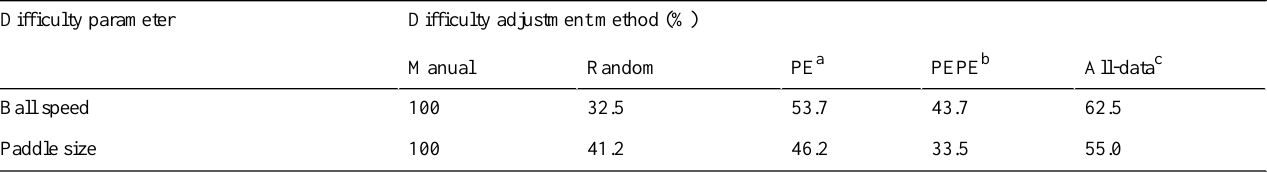
Table 2. Prediction accuracy of changes to the game difficulty parameters.